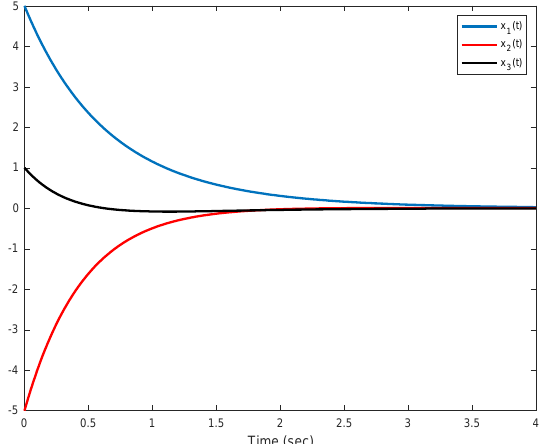
Figure 4. Evolution of the state space variables when the decentralized controller K d is used.